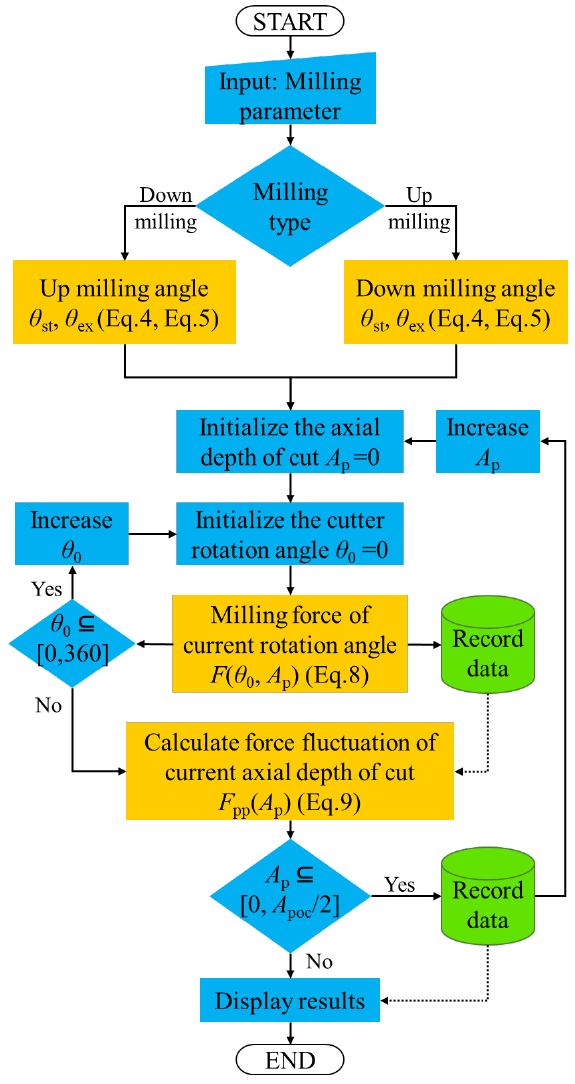
Figure 7. Simulation process of force fluctuation.